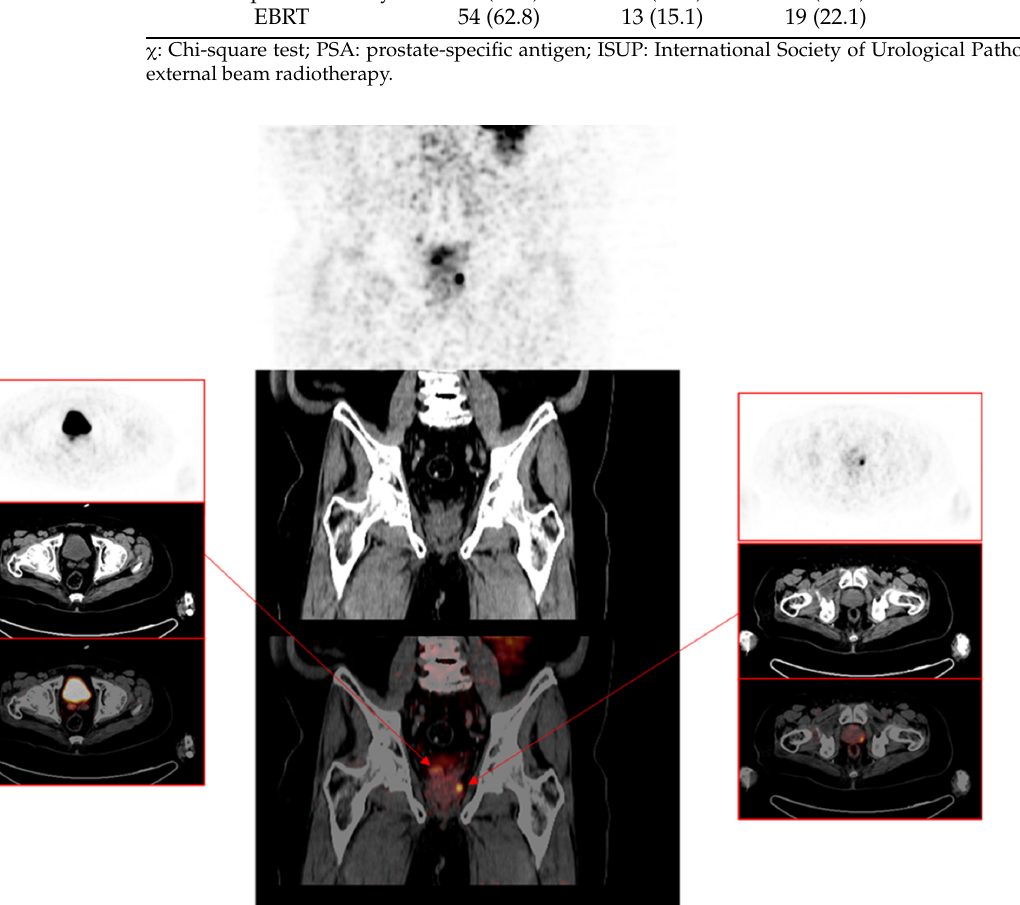
Figure 3. A 63-year-old male with a history of radical prostatectomy for adenocarcinoma of the prostate, Gleason 4+4. Ga- PSMA-11 PET/CT was requested for localization of disease recurrence at a serum PSA of 0.54 ng/mL. Images show intense tracer uptake in a subcentimeter left presacral node (straight arrows) and a subcentimeter left external iliac node consistent with the sites of prostate cancer recurrence.